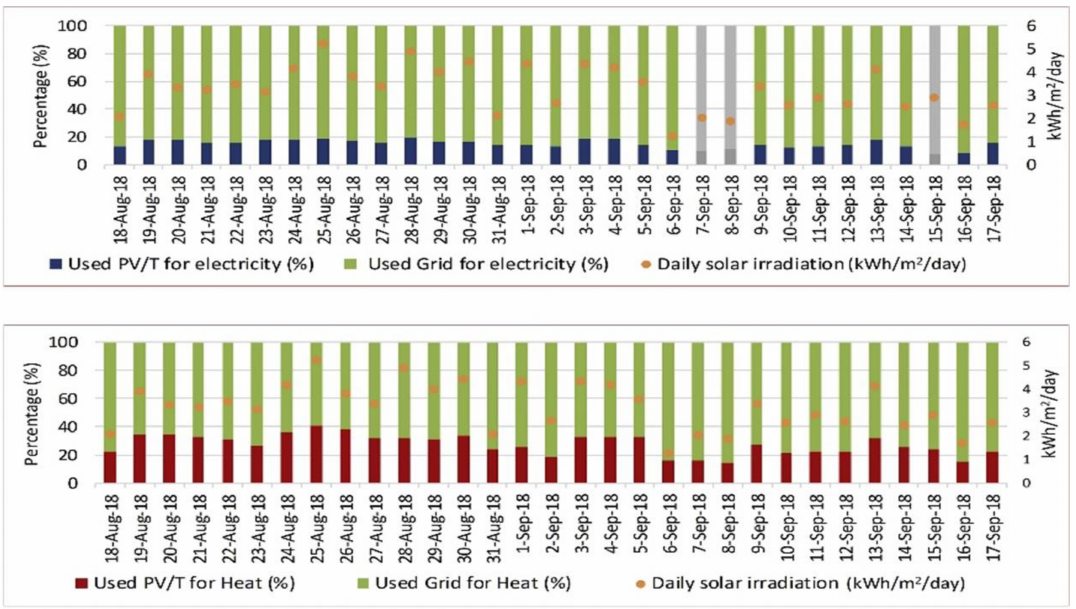
Figure 14. Percentage of PVT contribution to supply the electrical and heat demands for 31 days (reprinted from [93], with permission from